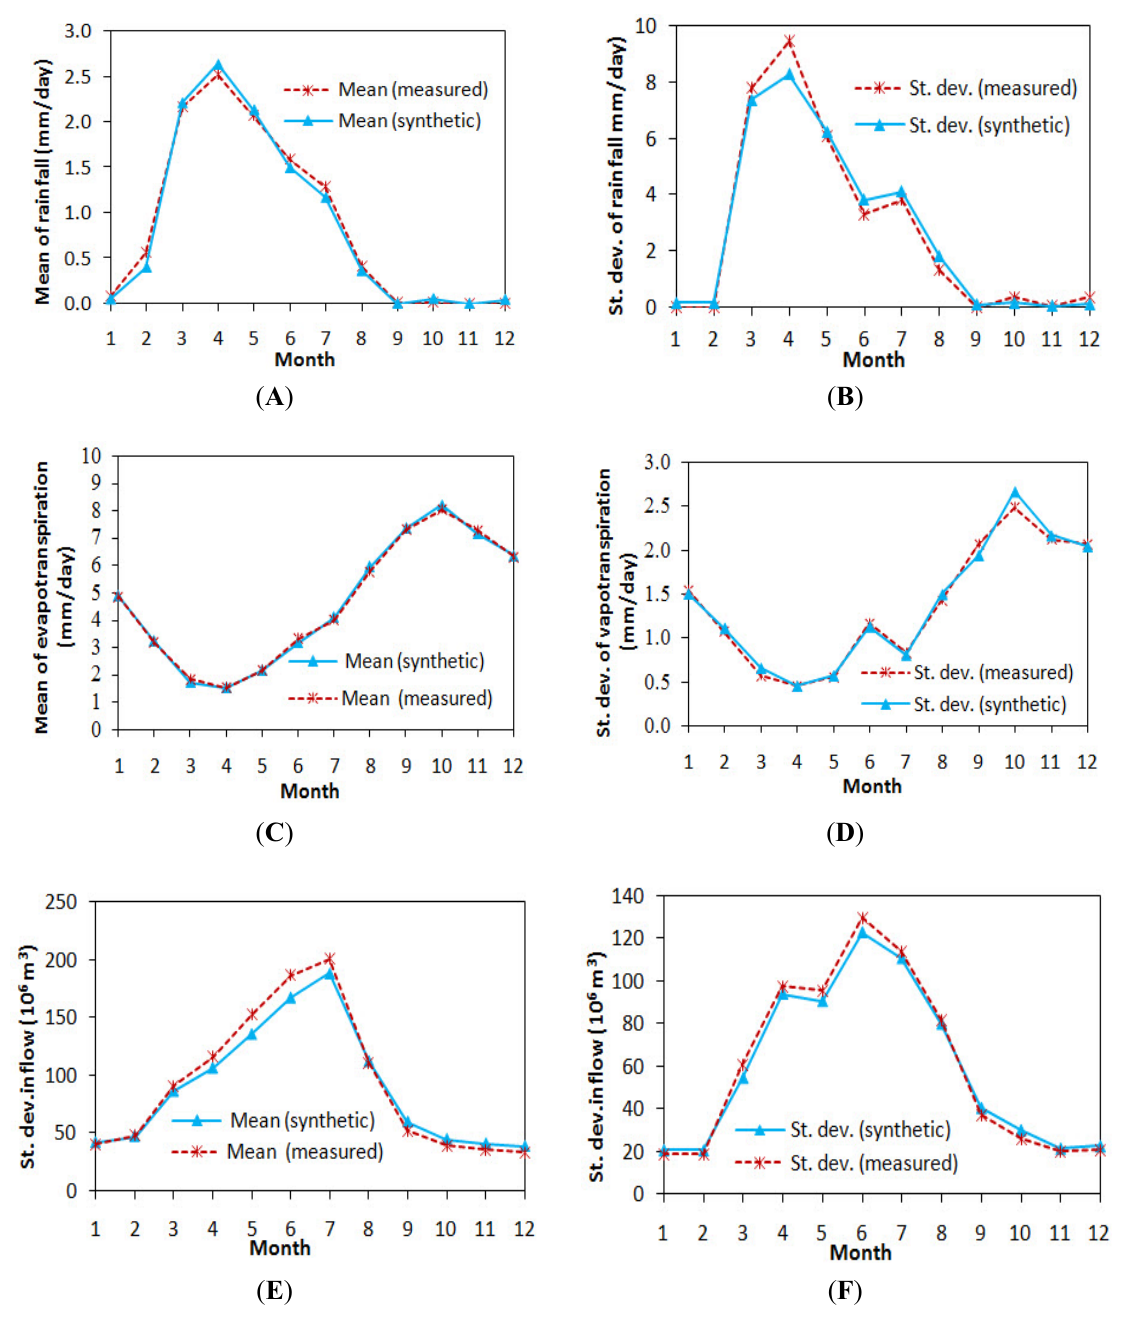
Figure 3. ( A ) means of rainfall; ( B ) standard deviation of rainfall; ( C ) means of evapotranspiration; ( D ) standard deviation of evapotranspiration; ( E ) means of inflow; ( F ) standard deviation of